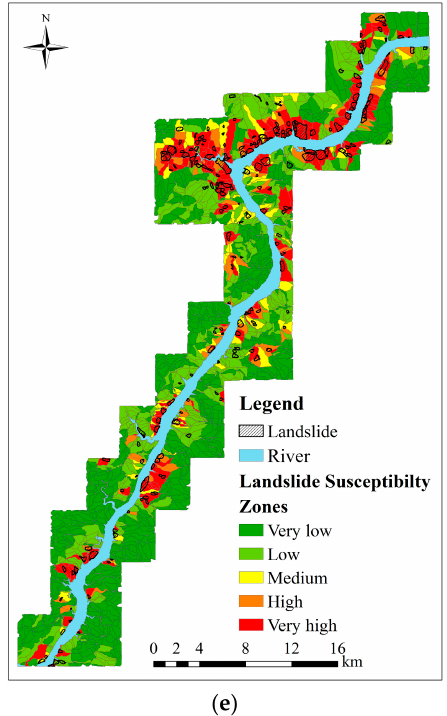
Figure 15. Landslide susceptibility zoning using the fixed interval method. ( a ) SVM; ( b ) PSO-SVM; ( c ) RS-SVM; ( d ) GWR-SVM; ( e ) GWR-PSO-SVM.